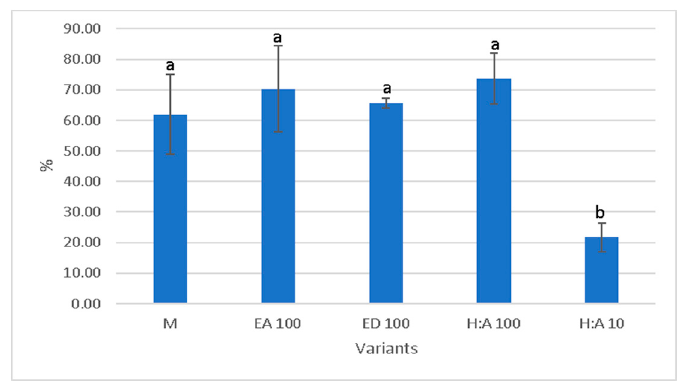
Figure 2. The influence of extracts on spore germination in Dryopteris filix-mas .